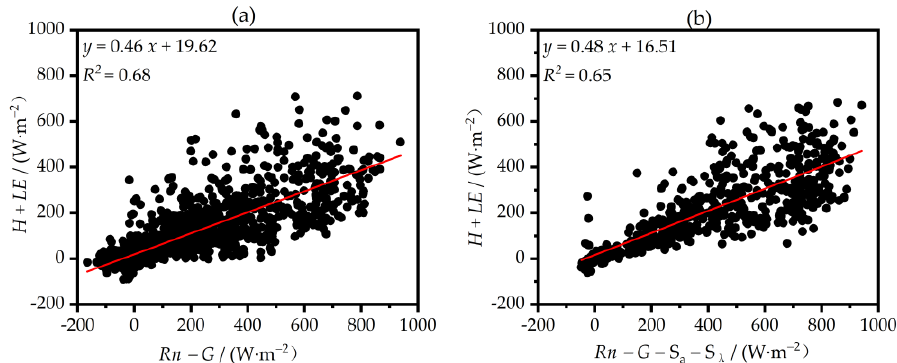
Figure 8. ( a ) Near-surface energy closure at Mount Emei station before considering canopy thermal storage. ( b ) Near-surface energy closure at Mount Emei station after considering canopy thermal